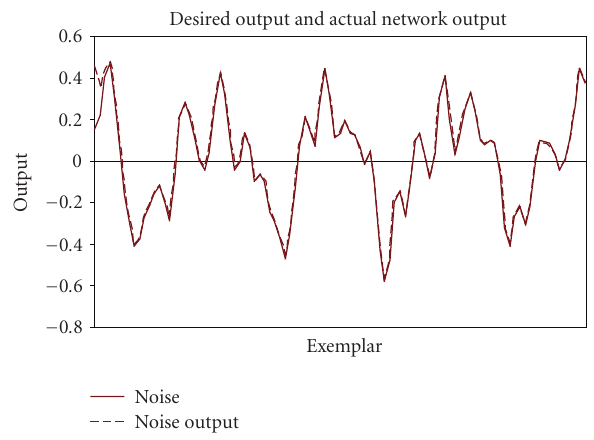
Figure 11: Modeling capability of FTLRNN on training dataset. Table 9: Variable parameters of RBF NN